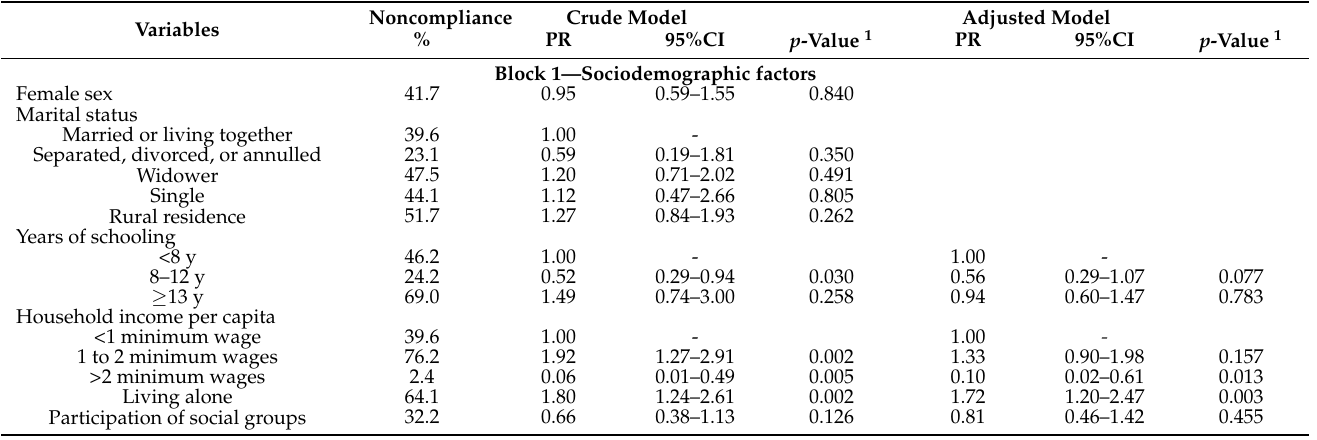
Table 4. Crude and hierarchically adjusted associated factors to food guideline compliance in elderly Chileans ≥ 80